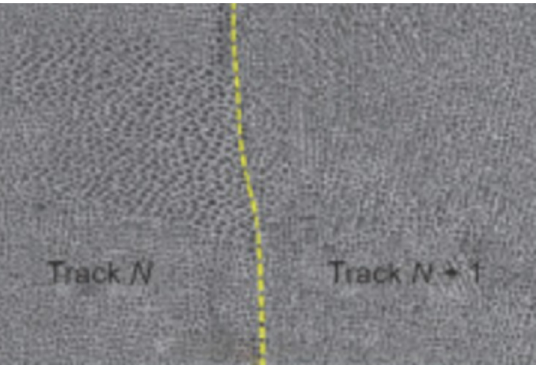
Figure 5. High magnitude microstructure morphology of top surface with laser power of 120 W [15].